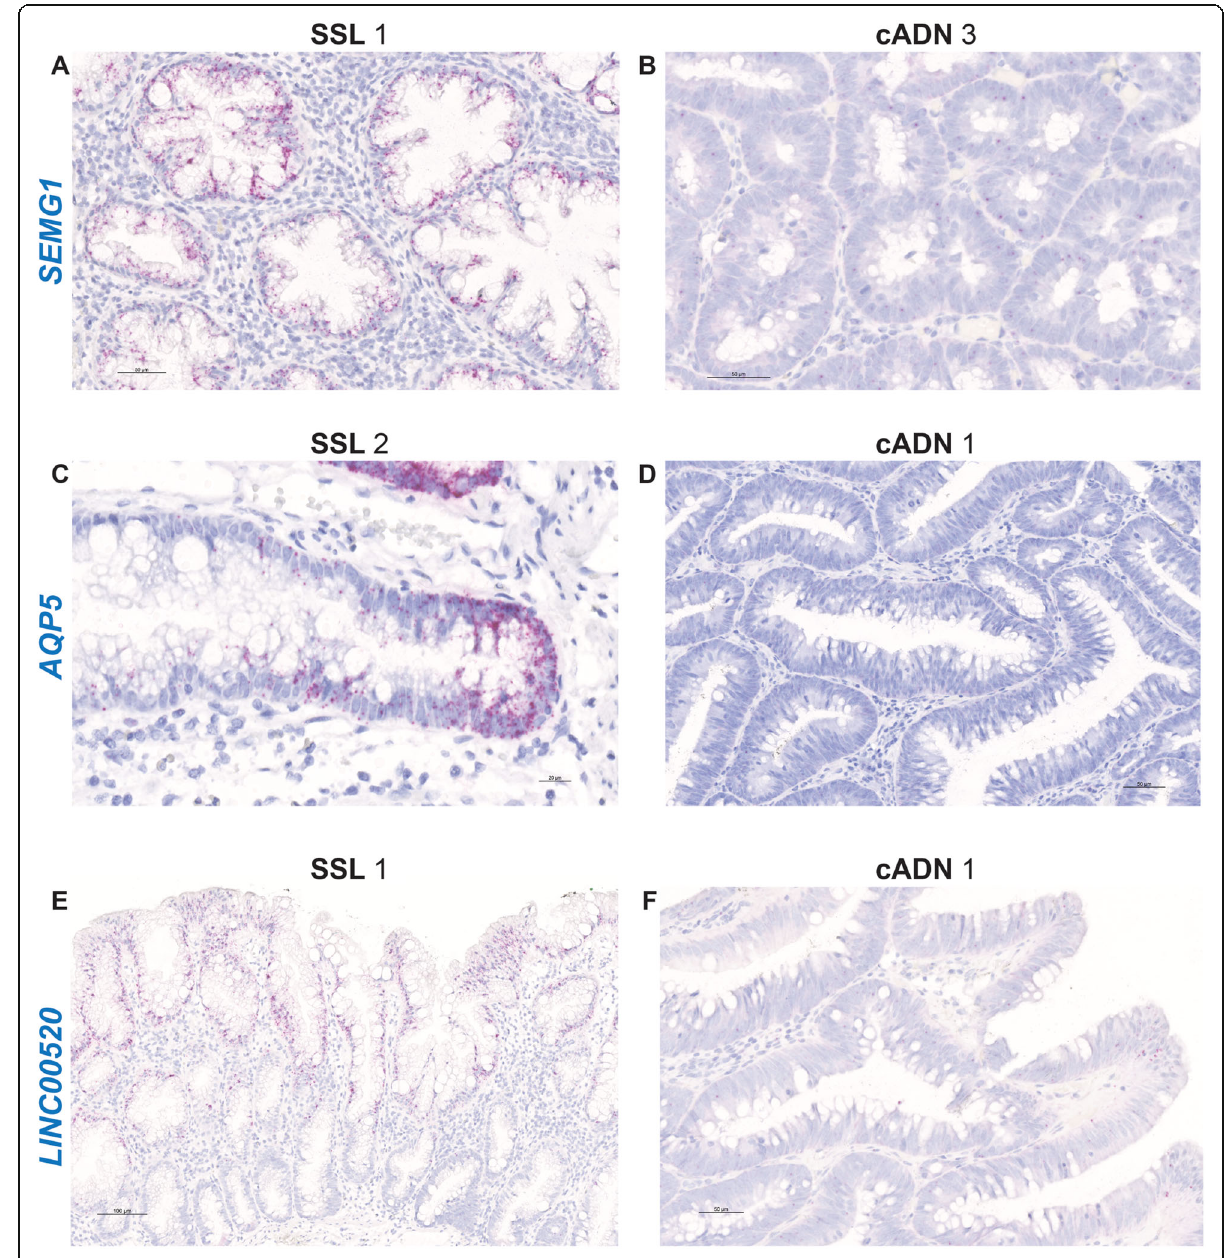
Fig. 3 In situ hybridization analysis of SEMG1 , AQP5, and LINC00520 RNAs in SSLs and cADNs. These three RNAs are “ moderately ” to “ very-highly ” expressed in SSLs, but absent in cADNs with the exception of few LINC00520 -positive superficial cells. Details on the expression patterns of these three RNAs in the investigated lesions and in normal mucosa are shown in Supplementary Figs. 7, 8, and 9, and summarized in Table